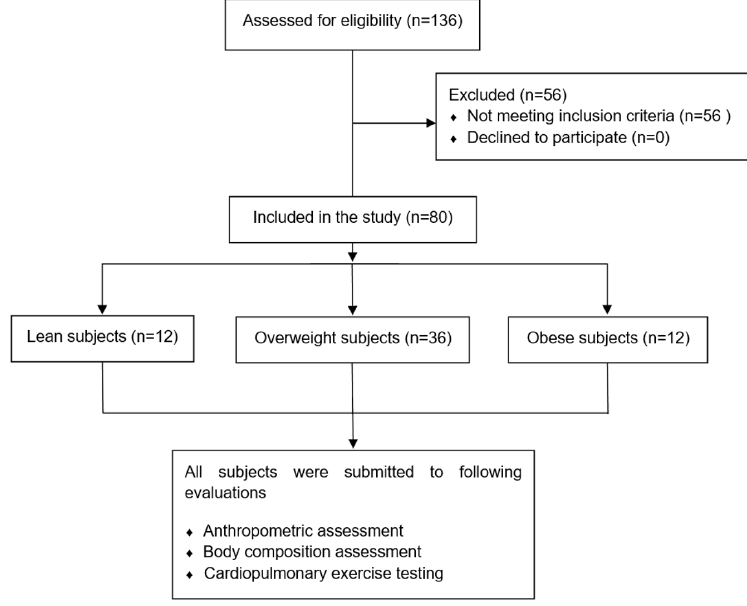
Figure 1. Flow chart for selection of study